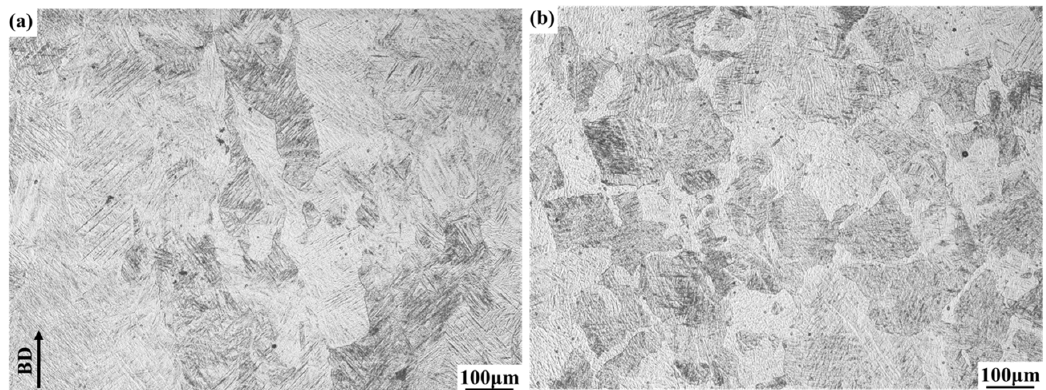
Figure 2. Optical microscope (OM) of SLM-fabricated Ti64 samples ( a ) side ( b ) top view.